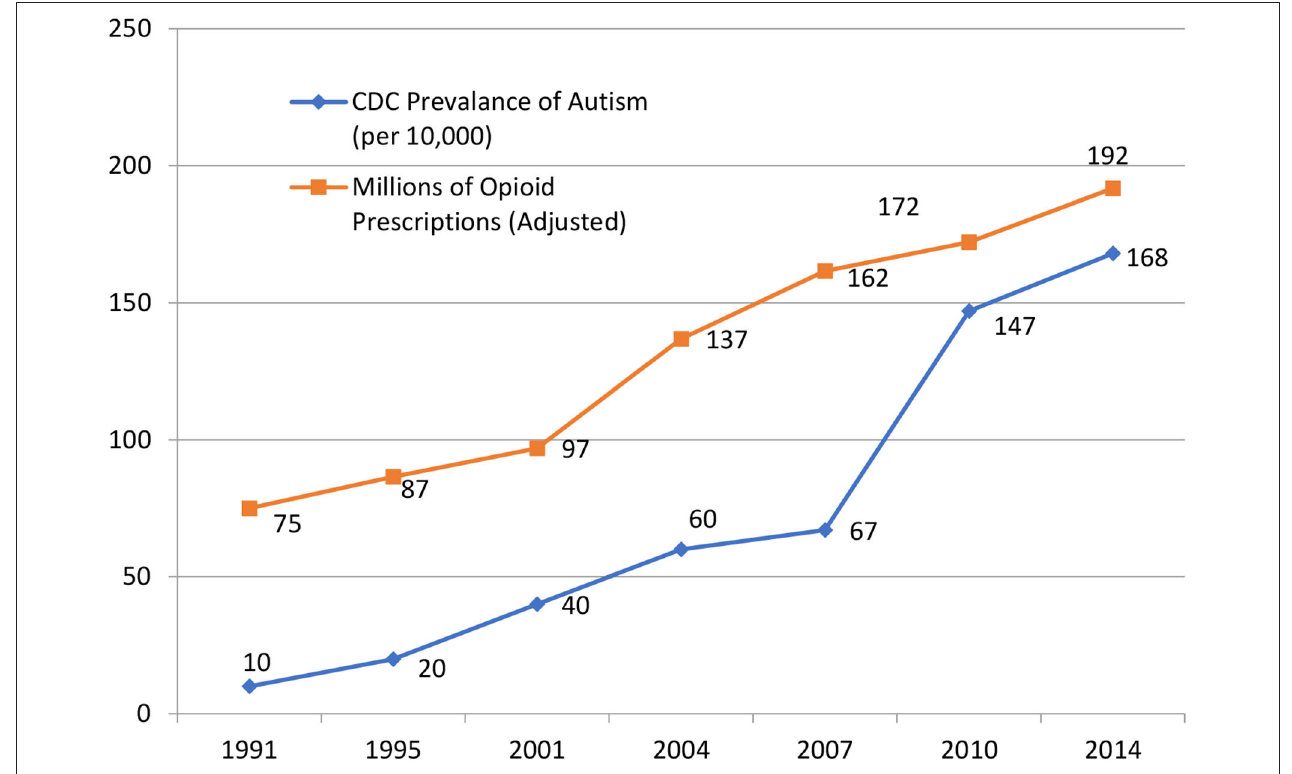
FIGURE 2 | Autism rate and opioid prescription correlation. Correlation p < 0.001.